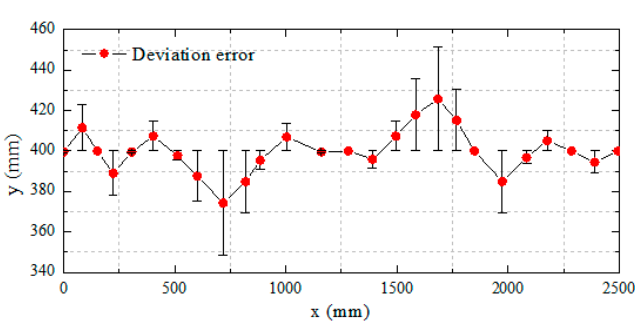
Figure 14. Deviation error curve in the y-axis direction.